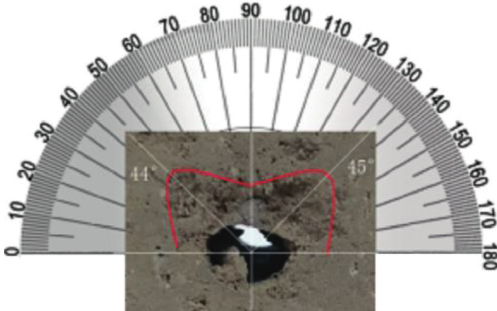
Figure 7: Plastic failure of soil around the drilling hole.